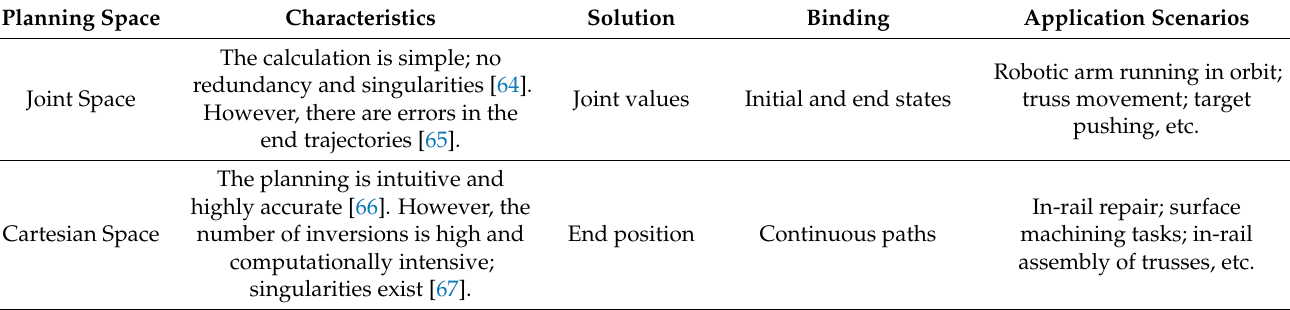
Table 2. The comparison of spatial robotic arm trajectory planning performance